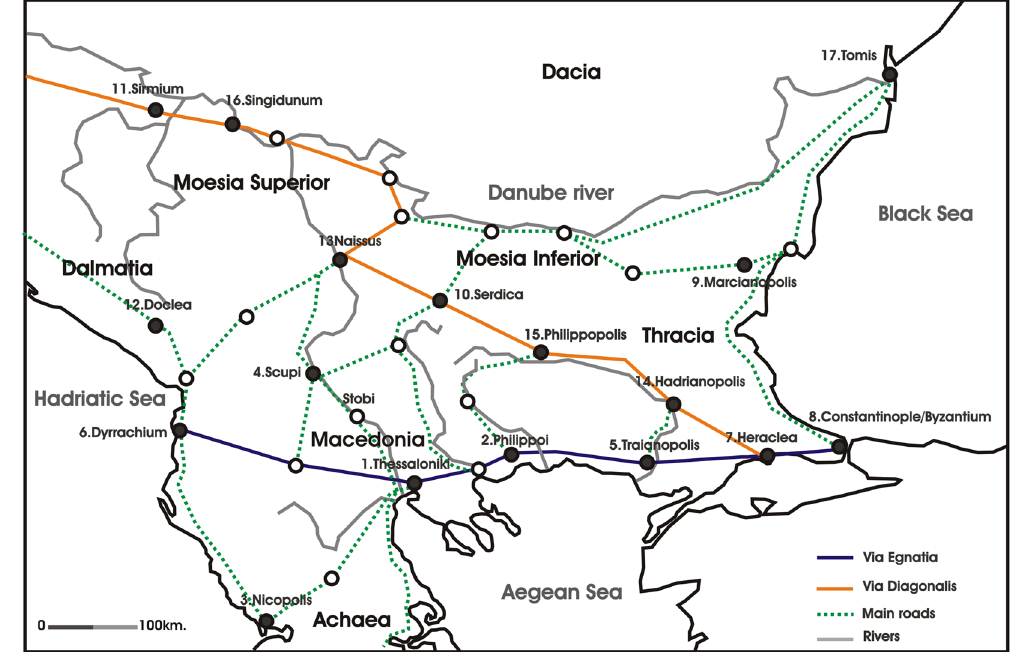
Figure 1. Roads and major sites in the Balkans during the imperial period (Figure prepared with Corel Draw R10 10-410 edition. Copyright 2015 V. Evangelidis. All rights